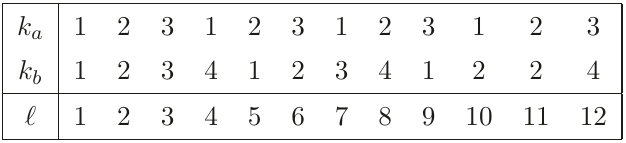
Table 1 . Index ℓ for bifundamental of U(3)